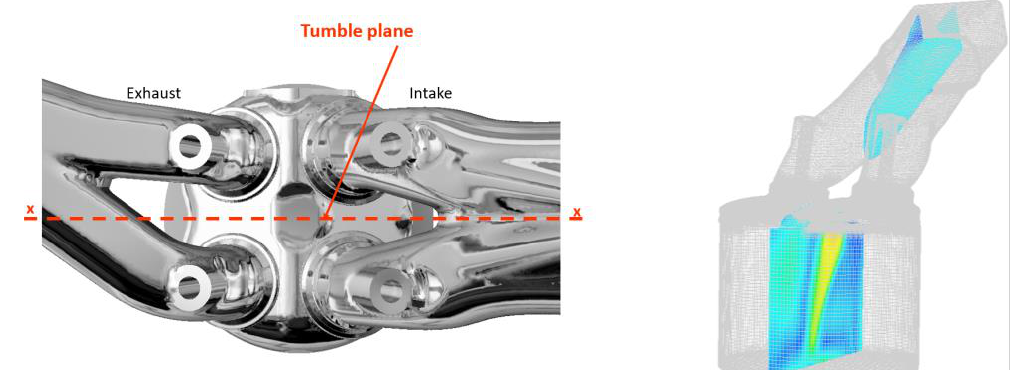
Figure 1. The tumble plane investigated with the particle image velocimetry (PIV).